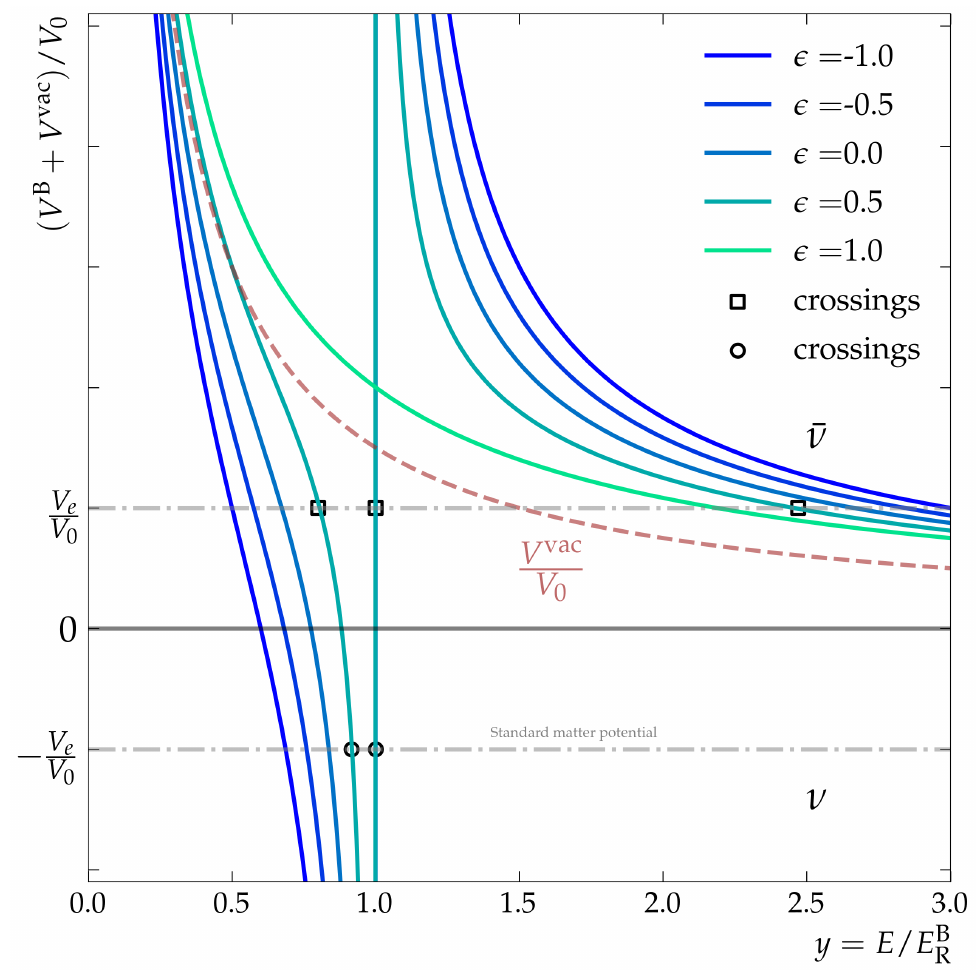
Figure 3 . The dependence of the total potential, ( V B + V vac ) /V 0 , on energy y for different values of (cid:15) . The horizontal lines correspond to the usual matter potential V antineutrinos. Crossings of these lines with ( V B + V vac ) /V in the neutrino (empty boxes) and antineutrino (empty circles)